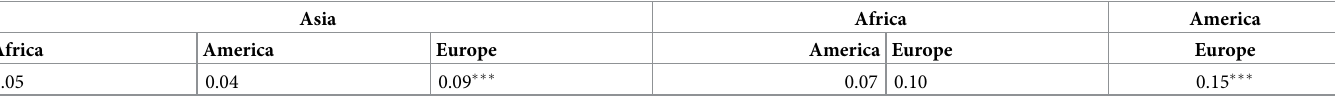
��� Significant at P � 0.001 (110